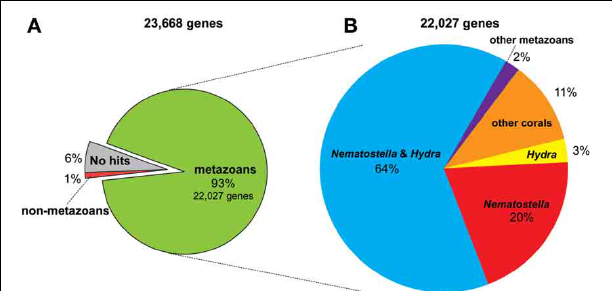
FIGURE 1 | The proportion of similarity of Acropora digitifera gene models to those of other metazoans (see text for the method). (A) The 93% (22,027) of the 23,668 gene models have similarity to other metazoans, while 1% of them for non-metazoans and 6% show no similarity to proteins deposited in NCBI database (NR). (B) Of the 22,027 metazoan-similarity genes, 64% had counterparts in both Nematostella and Hydra genomes, 20% of them for Nematostella but not in Hydra , 3% for Hydra but not in Nematostella, and 2% for other metazoans but not in Nematostella and Hydra . Eleven percent of them have corresponding ESTs of corals reported in NCBI.